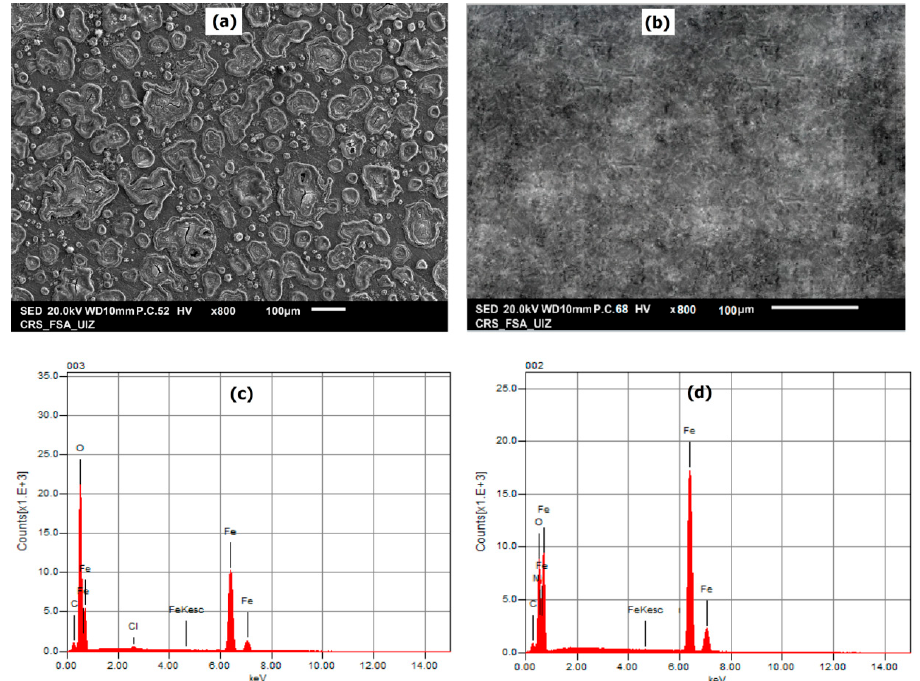
Figure 8. Scanning electron microscopy and energy dispersive spectroscopy images of the MS surface after 24 h immersion in 1.0 M HCl solution in the absence ( a , c ) and the presence of 5 × 10 − 3 M of MPH ( b , d ).